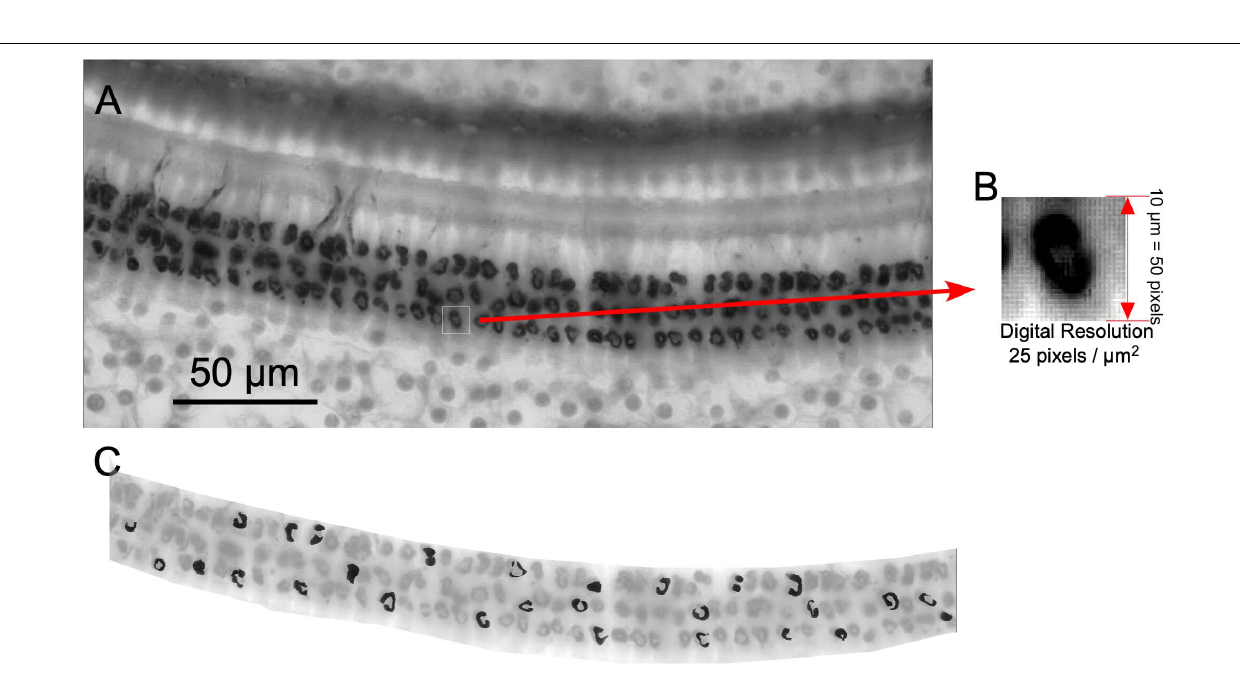
Frontiers in Neuroscience |